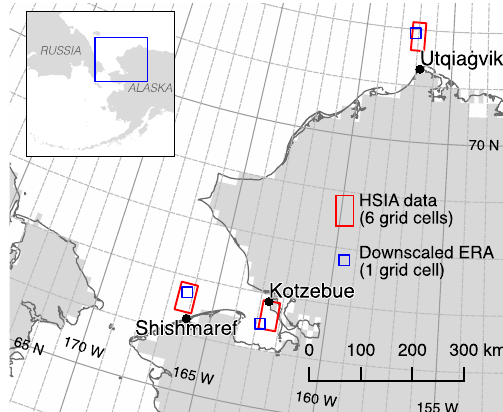
Figure 1. Selected grid cells from the Historical Sea Ice Atlas and WRF-downscaled ERA-Interim datasets used to extract sea ice con- centration (also wind speeds from the WRF-downscaled dataset) offshore several